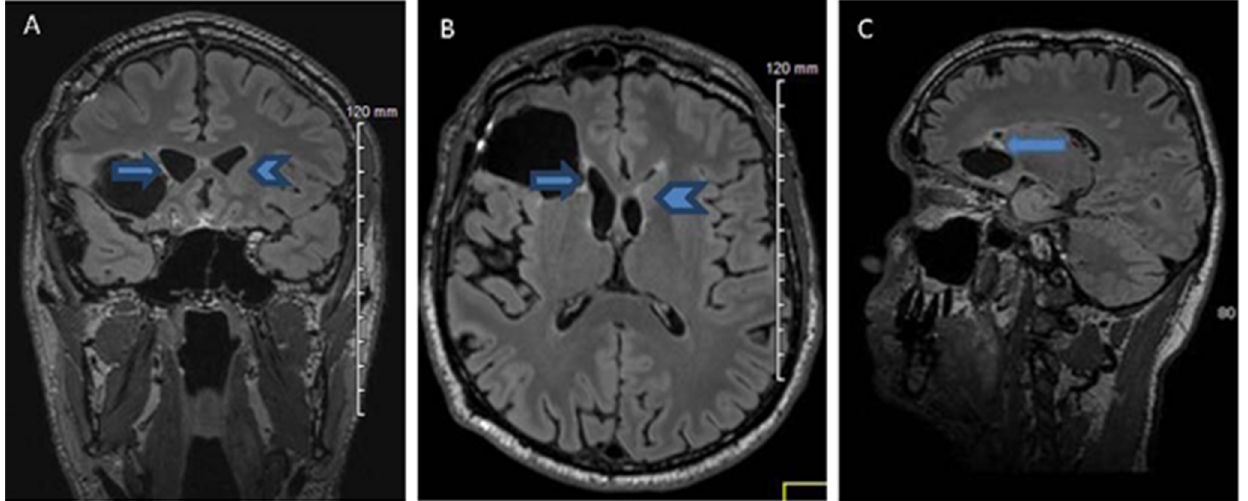
Figure 1. MRIs from MRI 31 months (January 2015) following the awake brain surgery: FLAIR Frontal ( A ), FLAIR Axial ( B ) and FLAIR Sagittal ( C ). Views showing supra-total resection with no visible recurrence of the tumour: head of left caudate ( A , B : arrow head); head of right caudate was partially resected ( A – C : arrow).